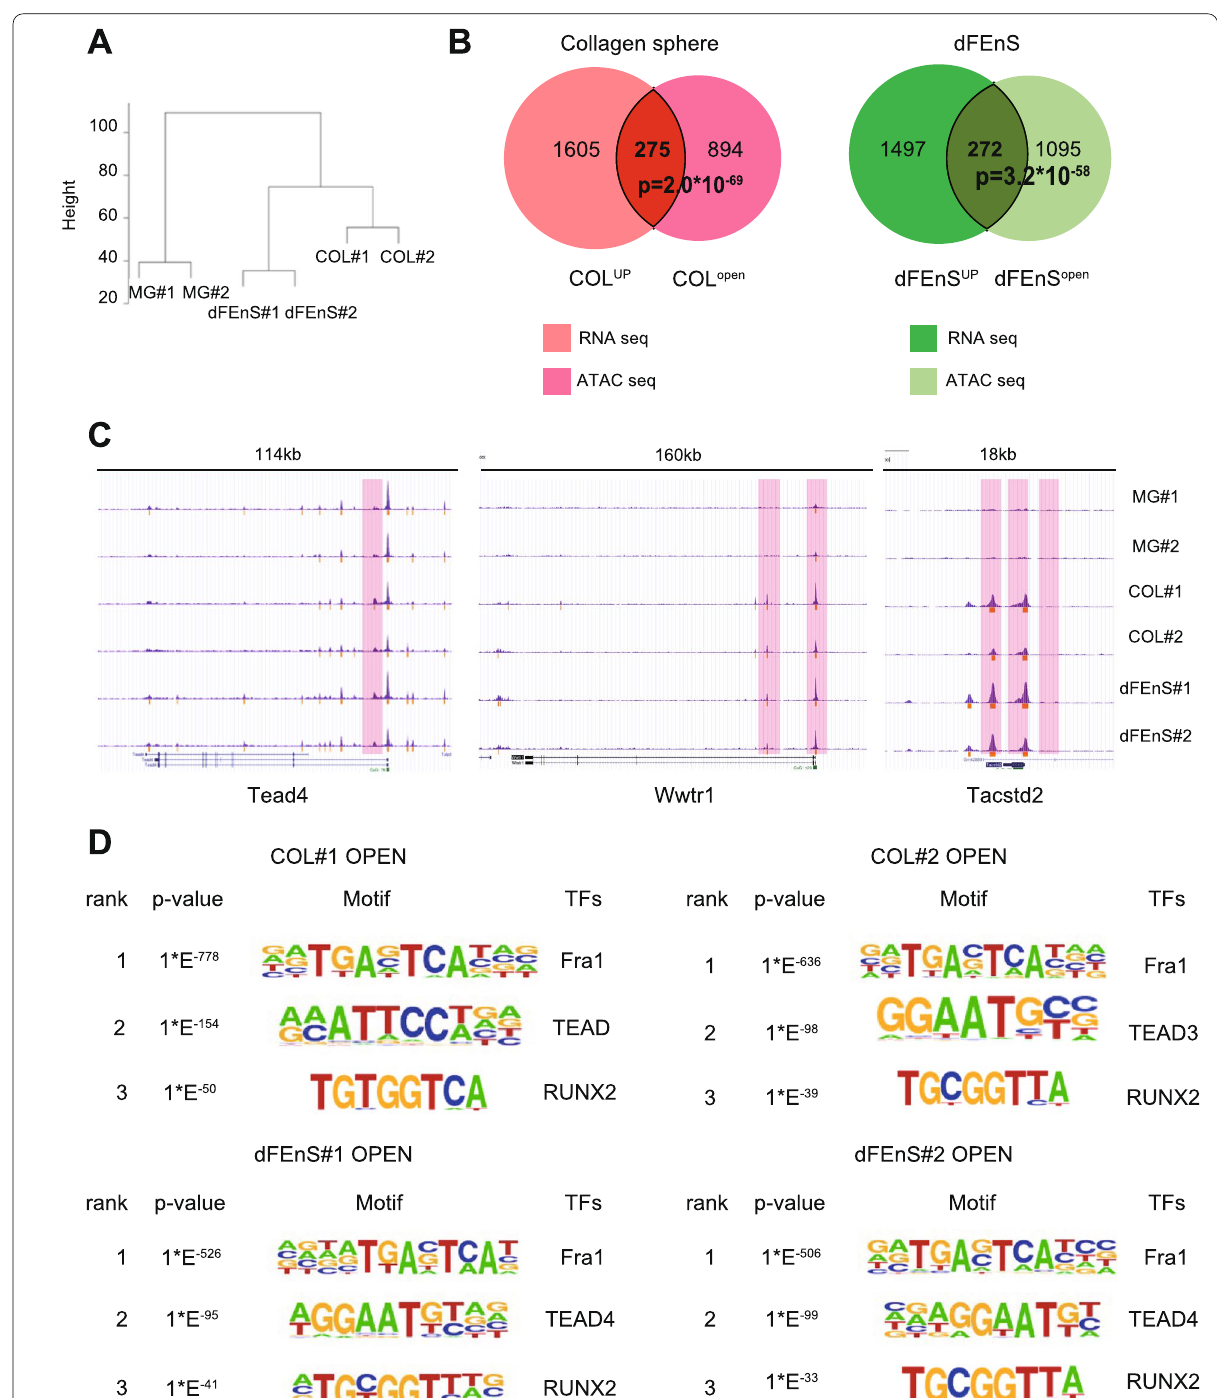
Fig. 3 Open chromatin status and transcriptional factors in the acquisition of inflammatory signature. A Hierarchical clustering analysis revealed chromatin accessibility among Matrigel organoids, collagen sphere, and dFEnS. B Overlap of COL‑UP (1880 genes) and FEnS‑UP (1769 genes) with genes showing adjacent COL‑OPEN (1169 sites) and FEnS‑OPEN (1367 sites) is visualized respectively. The p value of statistical significance is indicated. C ATAC sequencing tracks illustrate dynamic chromatin opening at Tead4 , Wwtr1 , and Tacstd2 in COL‑ENRWN and dFEnS. The open chromatin region is highlighted with a red bar. D Top three enriched TF motifs in open chromatin of the collagen sphere and dFEnS identified by ATAC sequencing analysis are